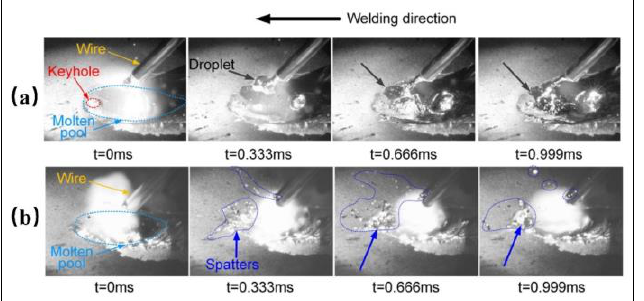
Figure 21. Droplet transfer behavior of aluminum alloy welding: ( a ) Laser – arc hybrid welding; ( b ) Arc welding [95]. Reprinted with permission from [95] 2019 Elsevier.